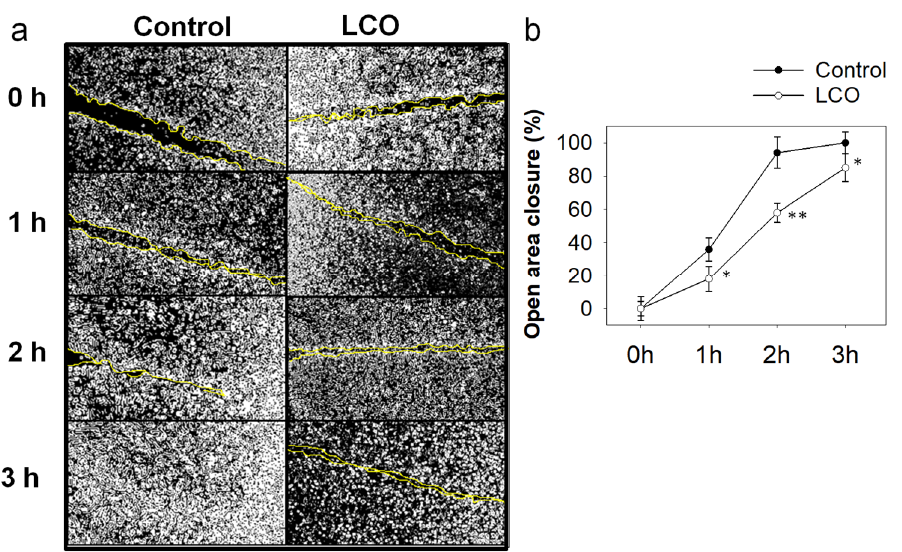
Figure 3. Effect of LCO on migration of cancer cells. Wound-healing assay for DA3 cells treated with 46 μg/mL LCO or DMSO for control. Migration rate of cells was monitored with an optical microscope equipped with a digital camera. ( a ) Photographs of the wounds captured at the indicated time points. ( b ) Quantification of the percentage of wound closure was estimated by ImageJ software analysis. Data are presented as the mean ± SD of three independent experiments. Asterisks indicate statistically significant differences (* p < 0.05, ** p < 0.005, Student’s t -test).